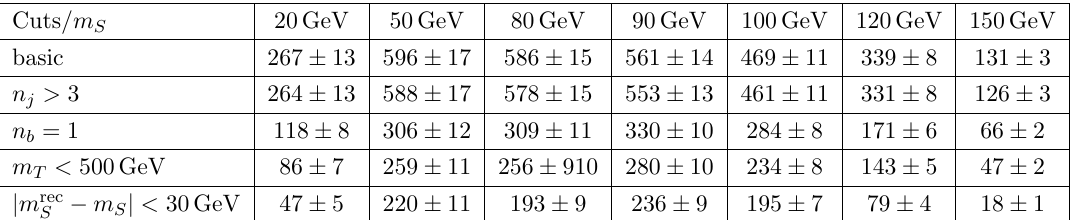
Table 5 . Event yields after each cut for the seven benchmark signal points, in the analysis for t ! Su; S ! (cid:28) + (cid:28) (cid:0) . We use Y 13 = Y 31 = 0 : 1, (cid:3) = 1 TeV and B ( S ! (cid:28) + (cid:28) (cid:0) ) = 1. The event yields presented assume a collected luminosity of L = 150 fb (cid:0) 1 .